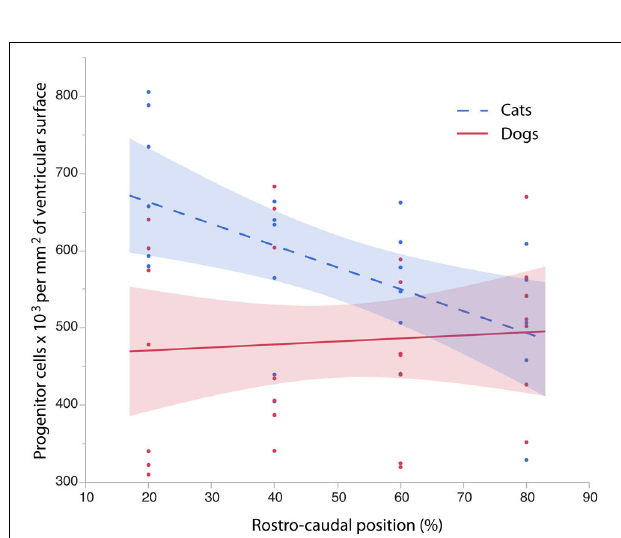
FIGURE 4 | The progenitor cells per mm 2 of ventricular surface are regressed against translated age at different sites across the rostro-caudal axis (i.e., 20, 40, 60, 80%). Twenty percentage stands for the most rostrally-selected region and 80% stands for the most caudally selected region. A linear regression and 95% confidence intervals are fit for each of the selected sites for each species. The duration of cortical layers VI-II neurogenesis in the primary visual cortex are shown for the cat.